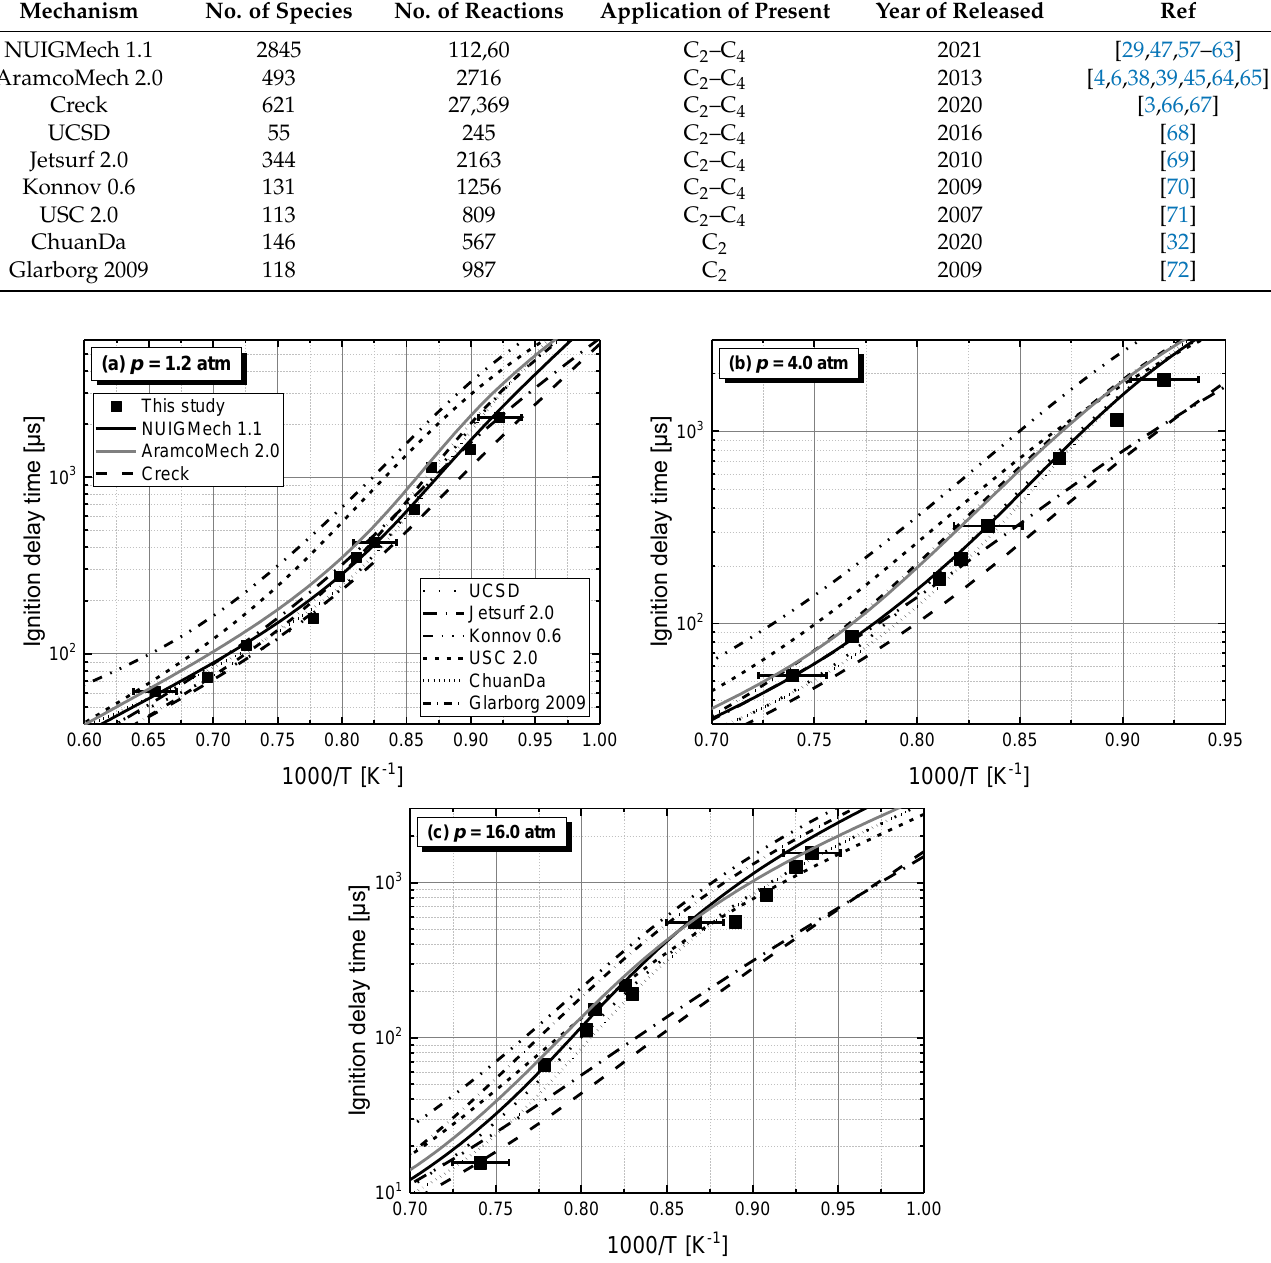
Figure 5. Comparison of measured and simulated IDTs of ethylene with shock tube at 1.2 atm ( a ), 4.0 atm ( b ) and 16.0 atm ( c ). Symbols: experiments in this study, lines: model simulations.